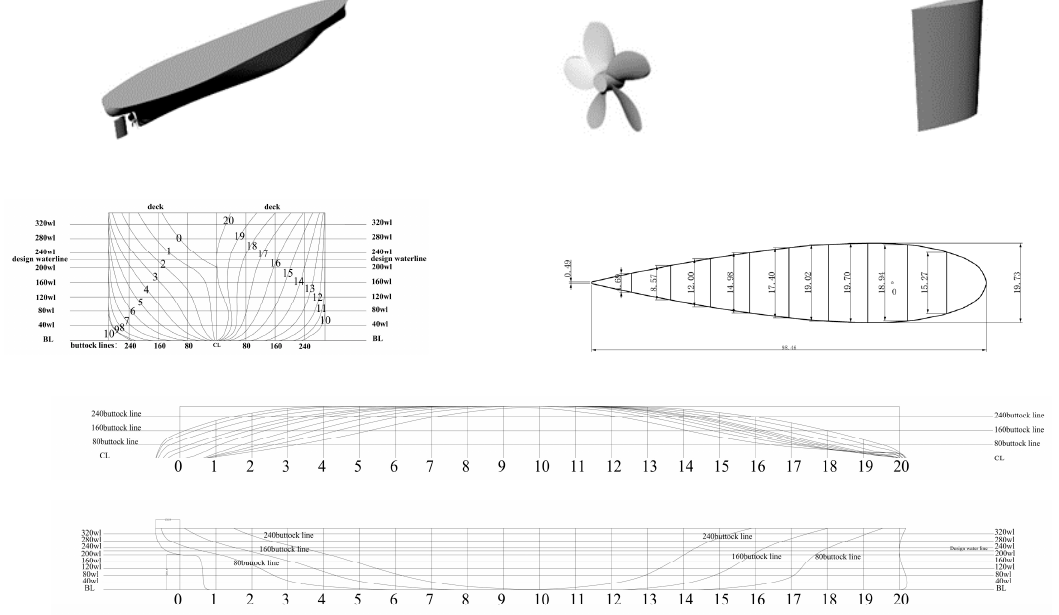
Figure 4. Geometry and lines of the S175 (hull, propeller, and rudder).